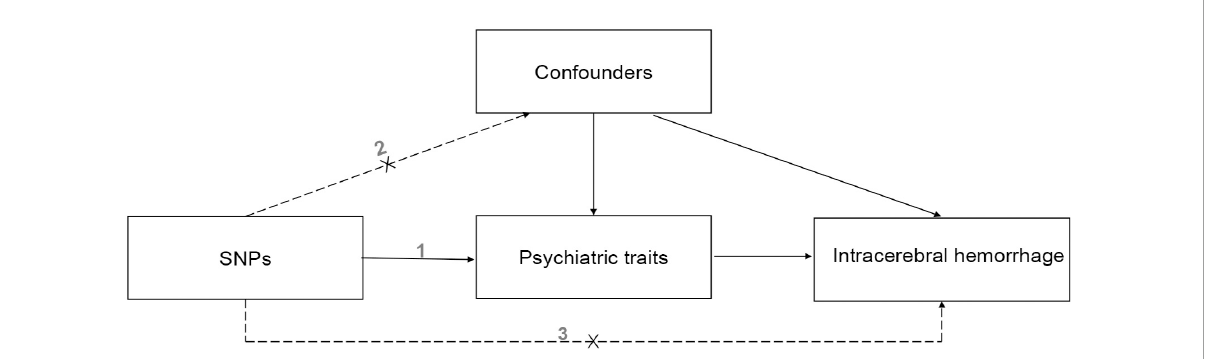
FIGURE1 The causal directed acyclic graph of the Mendelian randomization study. The design hypotheses are that the genetic variants are associated with psychiatric traits, but not with confounders, and the genetic variants are associated with the risk of ICH only through psychiatric traits. And similar hypotheses are applicable for the reverse MR analysis. SNP, single nucleotide